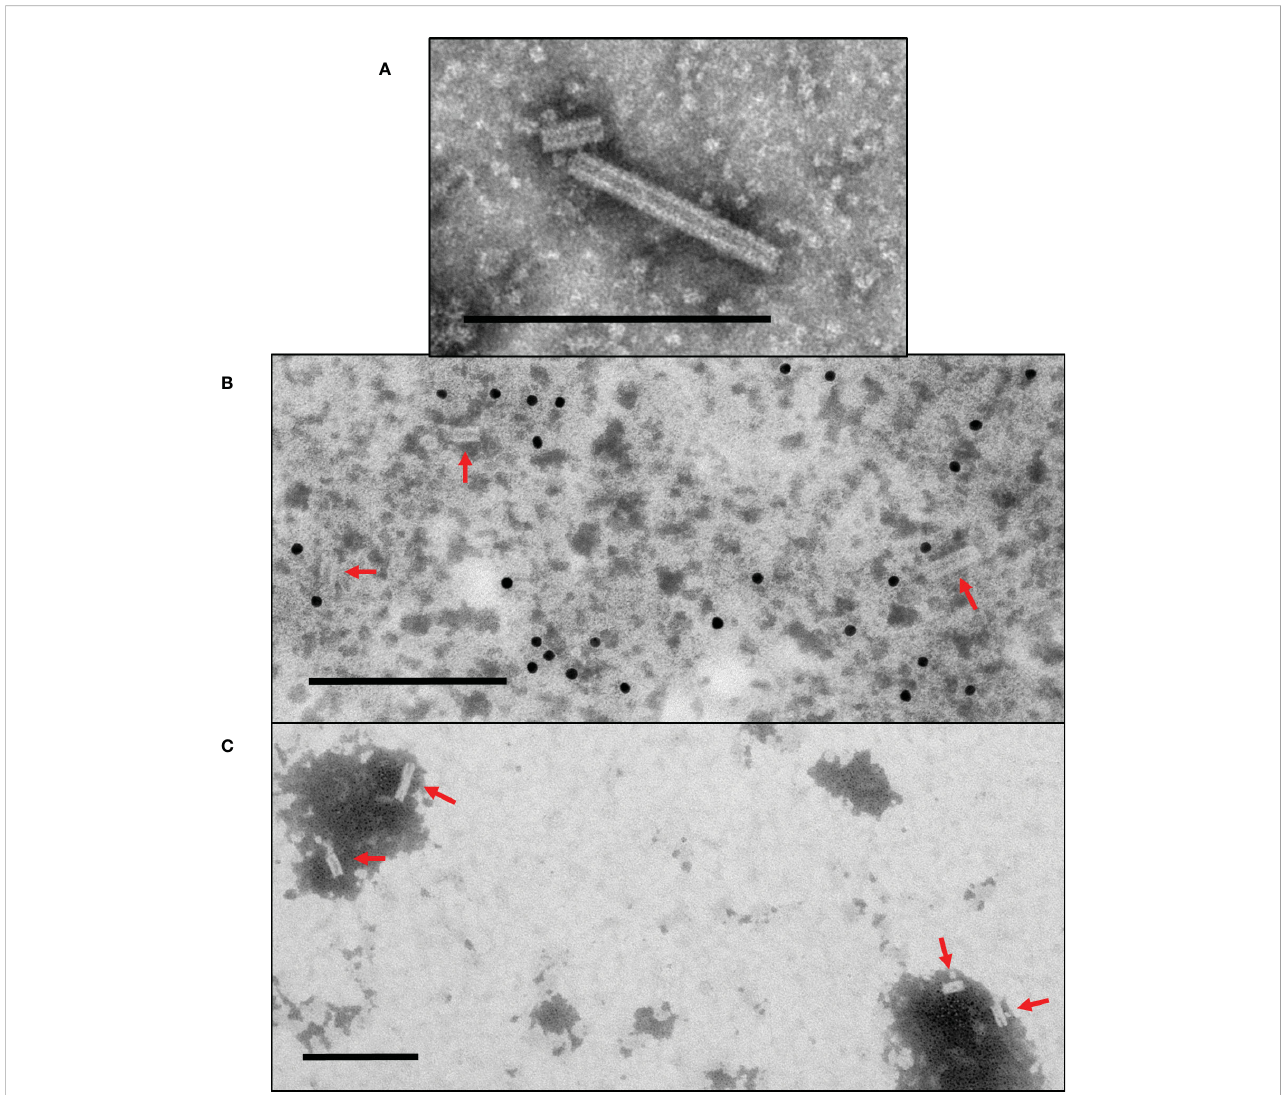
FIGURE 5 Plant-produced TMVc-M-GP5 assembles into nanorod structures surface-displaying the PRRSV epitope. (A) The modi fi ed TMVc-M-GP5 fusion protein self-assembles into nanorod structures of varying lengths. (B) TMVc-M-GP5 with immunogold localization using anti-c-Myc primary antibodies. Gold particles (10 nm) bound close to the nanorod structures indicate that the PRRSV epitope are displayed on the VLP surface. (C) Negative control for immunogold localization of TMVc-M-GP5, using no primary antibody for detection. Nanorods are present but no gold particles are visible surrounding VLPs. Scale bars represent 200 nm, and nanorods are denoted with red arrows. All protein samples were targeted to the apoplast and sampled on 7 dpi. Partially puri fi ed VLP extracts were negatively stained and examined using a TEM (JEM-1400, JEOL) operated at 80